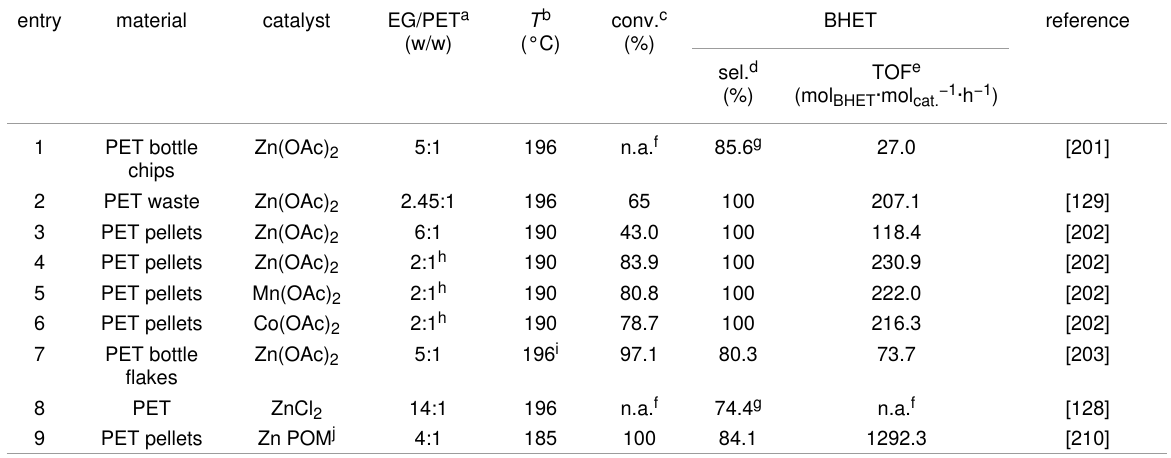
Table 2: Catalytic EG glycolysis of PET by metal acetates or other soluble metal salts.